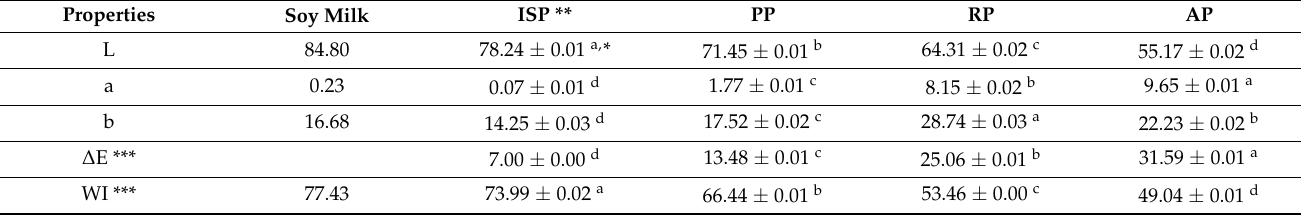
Table 3. Color of plant protein solutions (5%, w / w ) after fermentation.